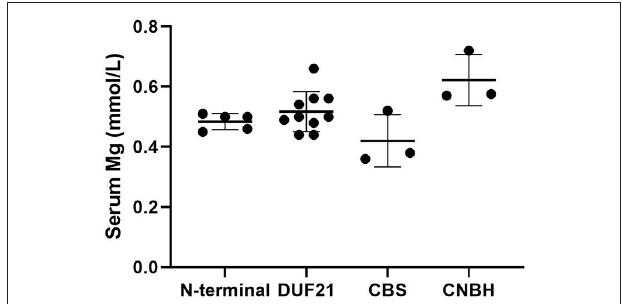
FIGURE 5 | Initial serum magnesium of patients with variants of different domains. We used one-way ANOVA to compare the difference. p =